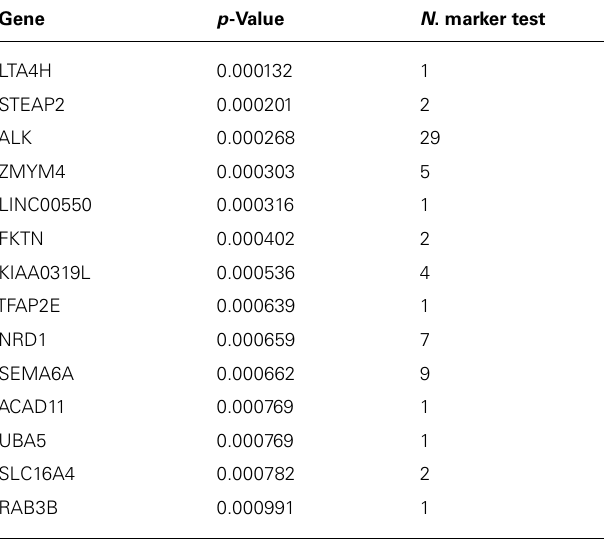
Table 2 | Rare variant results of high-IQ vs. low-IQ. Gene p -Value N . marker